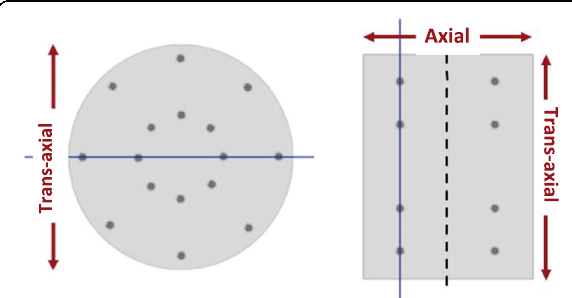
Fig. 1 (abstract A20). This figure shows the distribution of the 32 spheres in the cylinder. The cylinder was 35 x 23 cm (D x L) and had a background concentration of 0.1 μ Ci/cc. Sixteen spheres (eight each) were organized in an octagon at radii of 7 cm and 14 cm at z = ±5.75 cm with respect to the axial center (dashed black line)